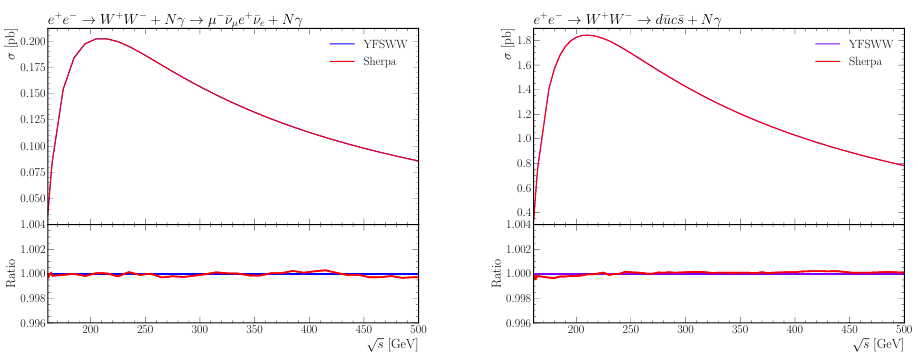
Figure 4: Total cross-section for hadronic and leptonic decay channel of e + e − → W + W − .